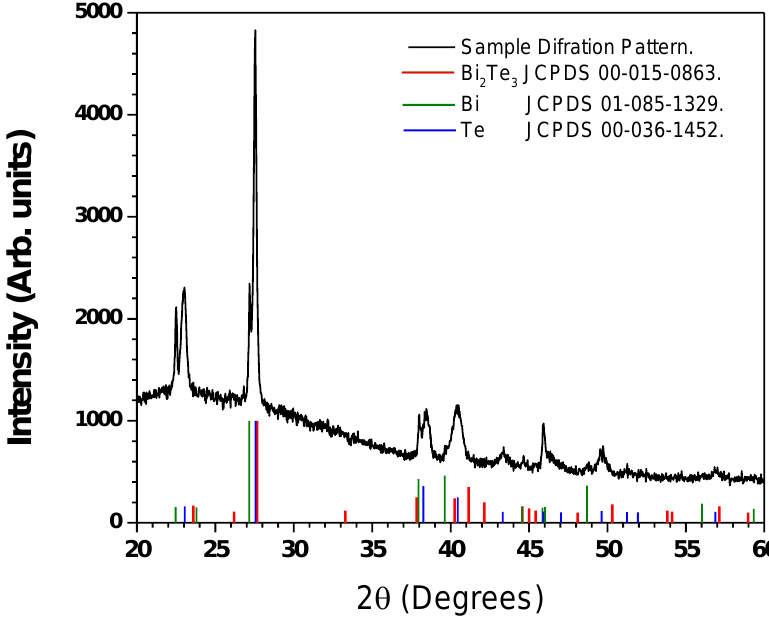
Figure 5. XRD Analysis of synthesized Bi 2 Te 3 film.